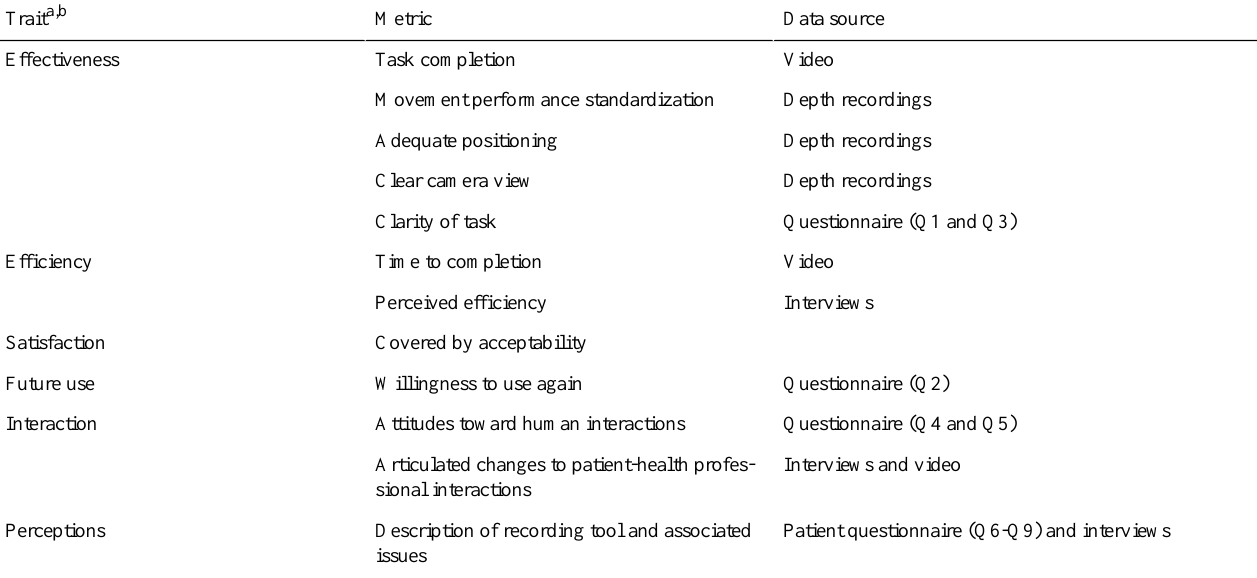
Table 1. Description of metrics used for each trait and the data source drawn